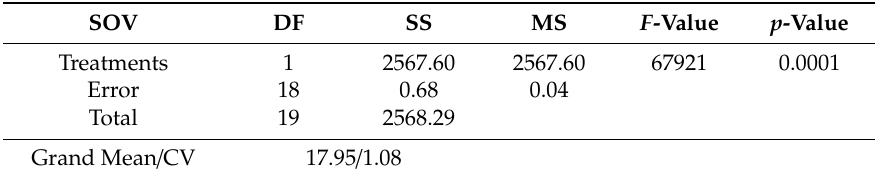
Table A12. Influence on the plant height of PeBL1-treated and control cucumber seedlings.